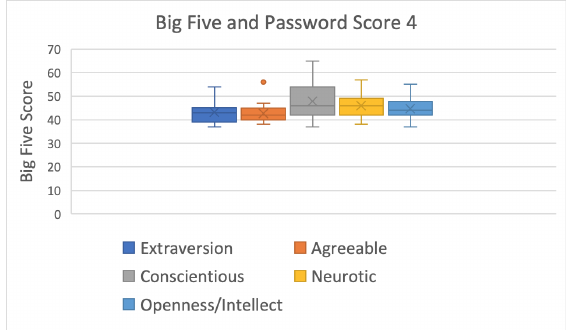
Figure 1. Breakdown of participants’ zxcvbn password strength scores.